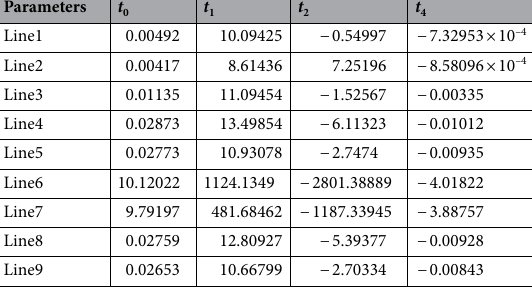
Table 4. Factors in Eq. (14).